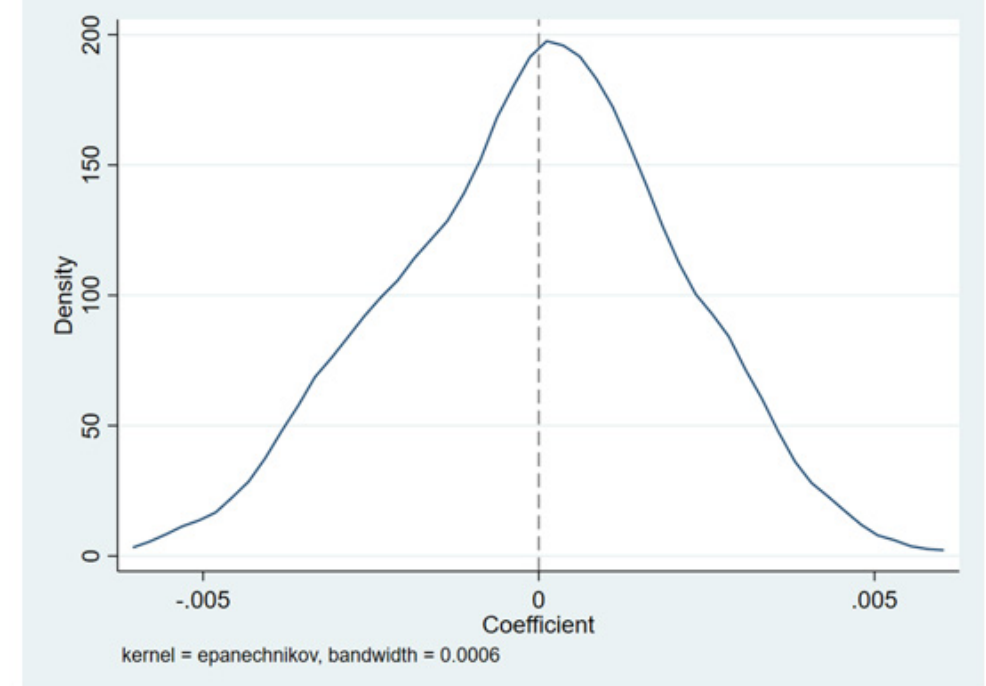
Figure 3. Placebo test for VAT reform randomness.